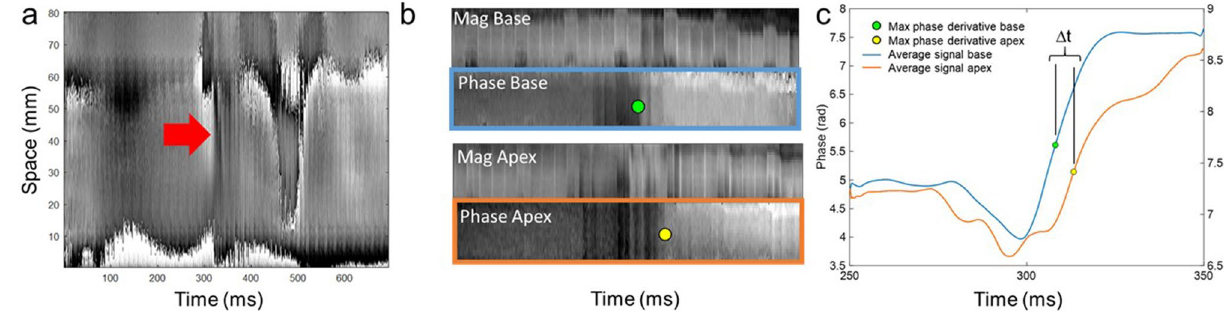
Figure 7. cNAVs positioned parallel versus perpendicular to the septum. ( a) A single pencil beam positioned parallel to the septum generates a space–time waterfall plot, where space covers almost the entire length of the septum (80 mm). The plot clearly shows a perturbation at the time of aortic valve closure (~ 330 ms) with an inclination that yields a shear wave speed of about 5 m/s. For this experiment, the motion encoding was